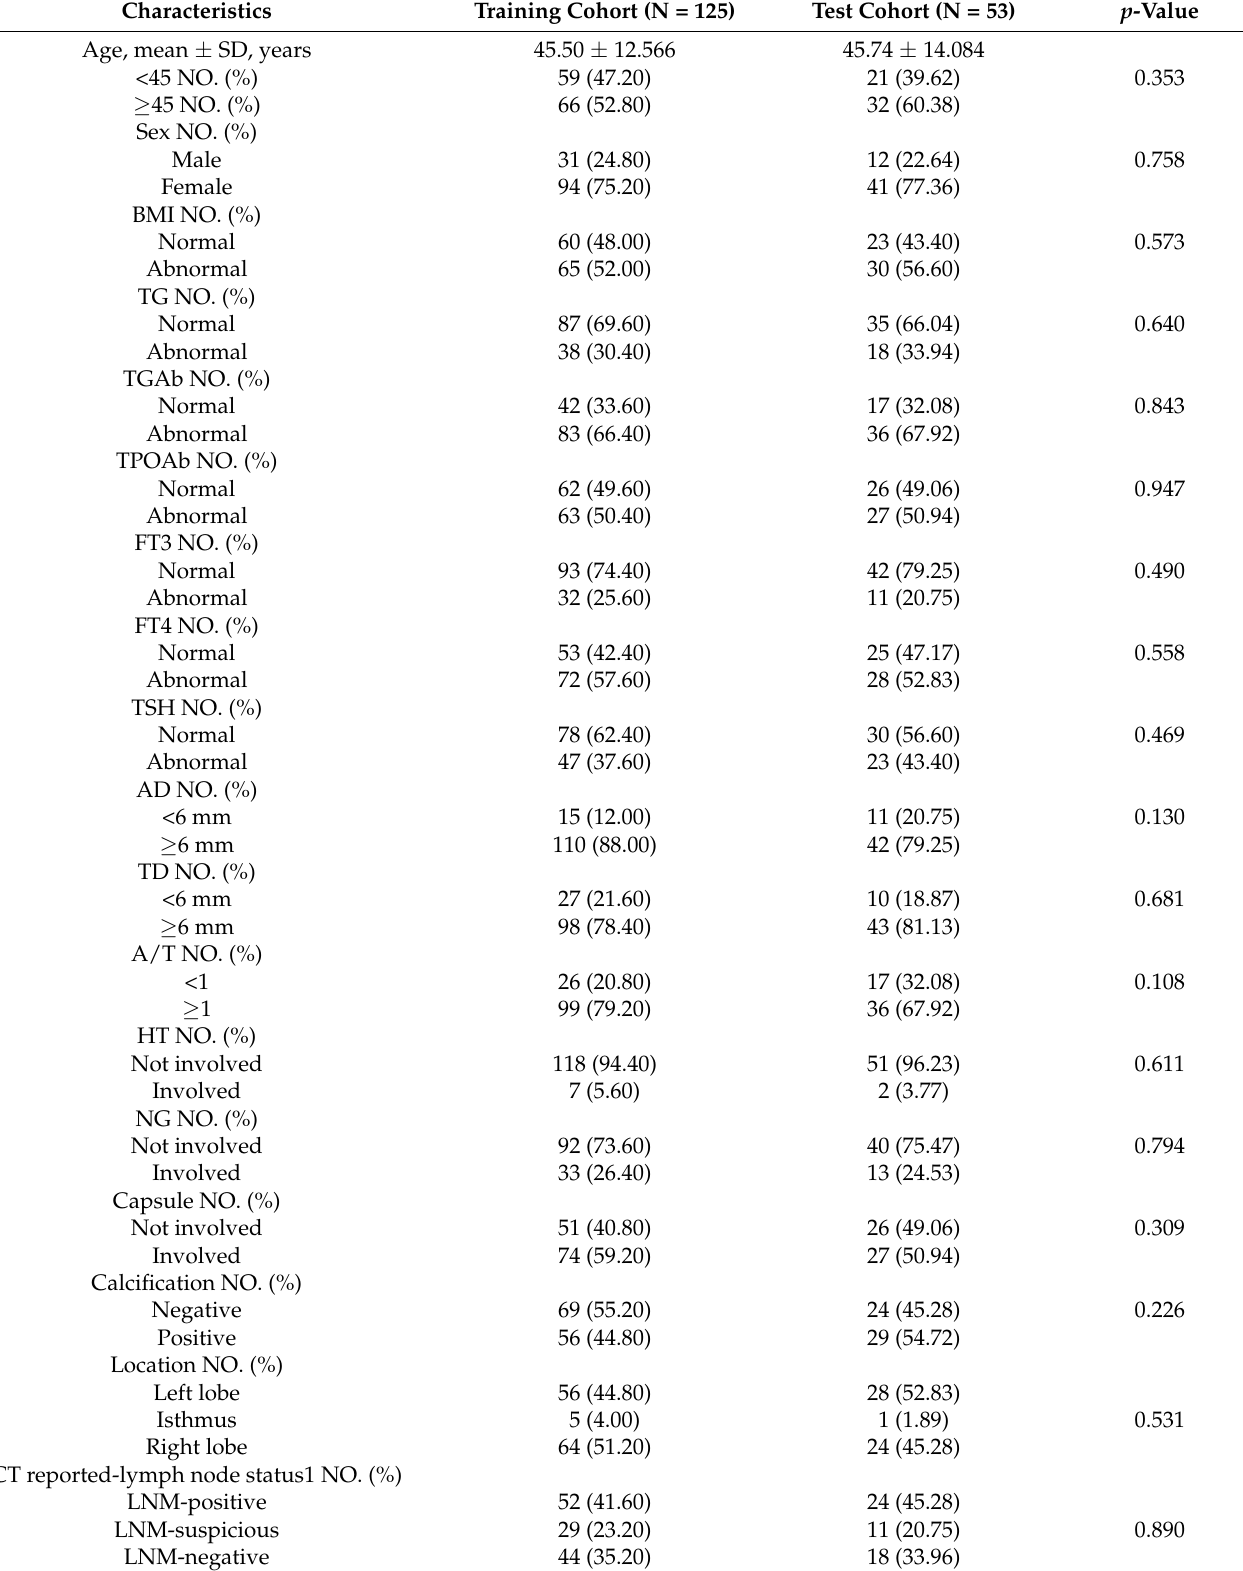
Table 3. Associations between actual lymph node status, clinical characteristics and CT-reported